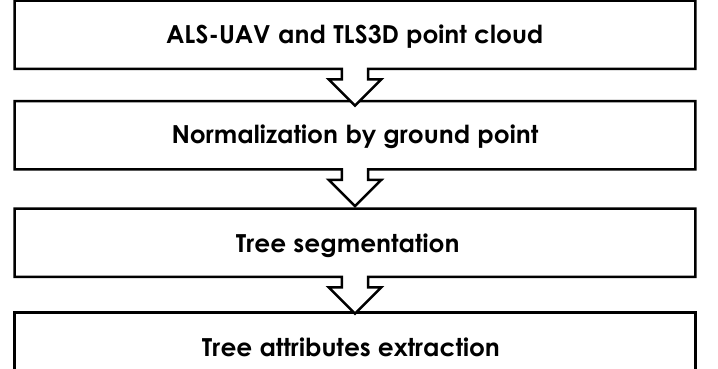
Tree attributes Tree attributes Figure 5. Processing steps of ALS-UAV and TLS 3D point cloud. Figure 5. Processing steps of ALS-UAV and TLS 3D point Figure 5. Processing steps of ALS-UAV and TLS 3D point cloud.